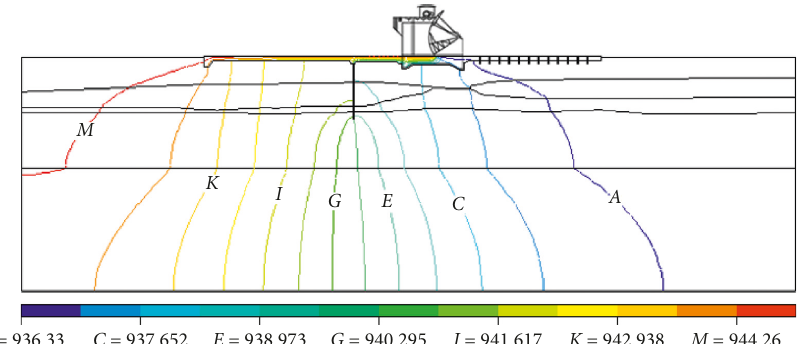
Figure 21: Total seepage head contour in 1# sluice foundation in dry